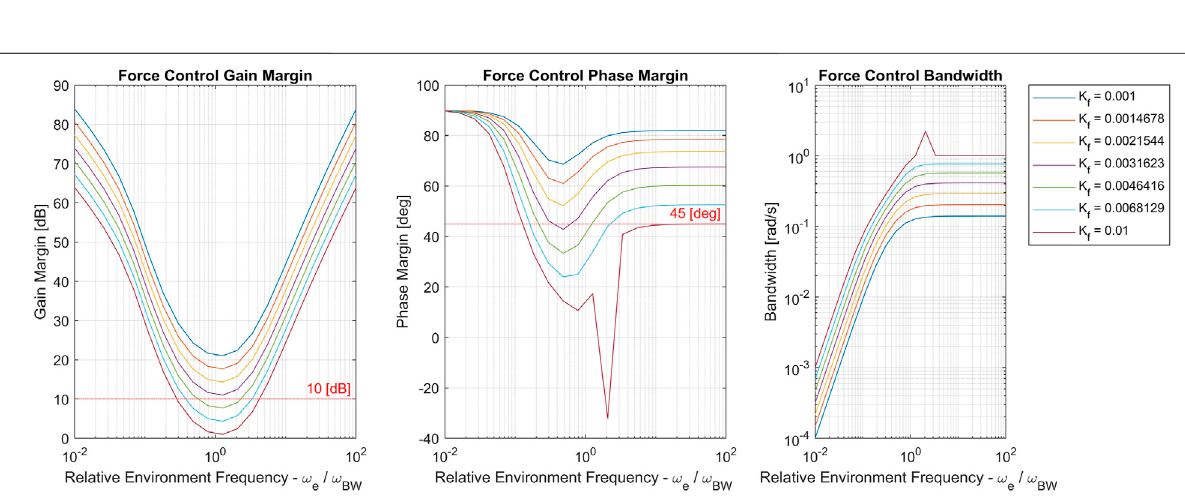
tip position is based on q 2 , freely vibrating state. A frequency response plot of the nominal loop gain compared to the perturbed loop gain is shown in Figure 10 . Note that the loop gain is clearly unstable for < 1. cases where ω o ω BW